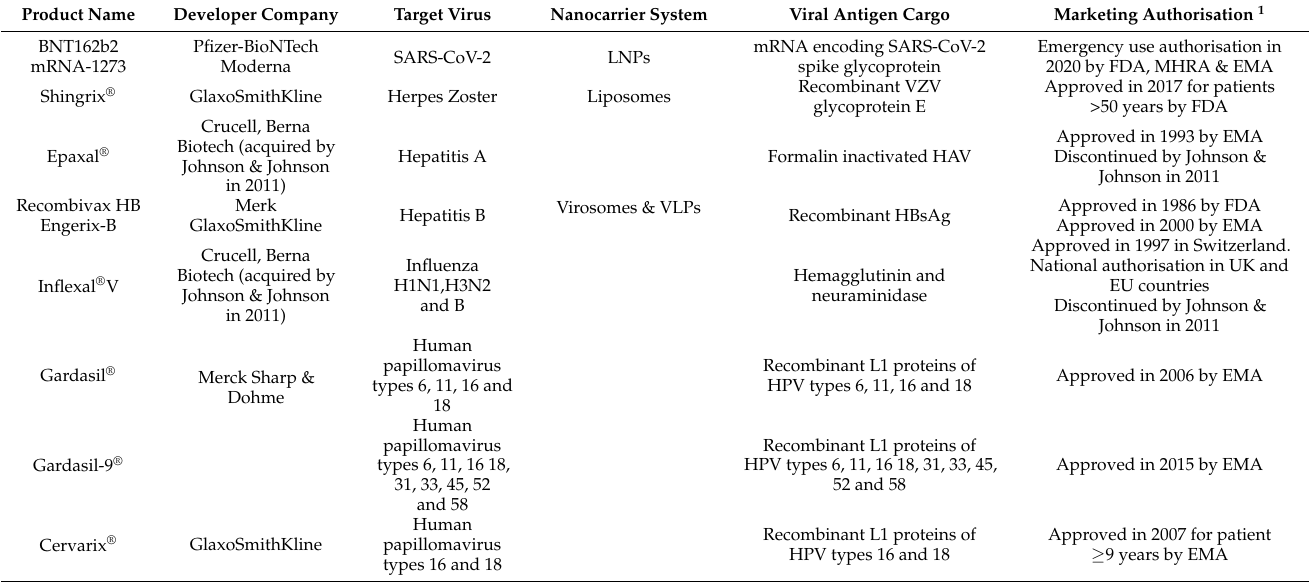
Table 1. Nanovaccines approved for clinical use by